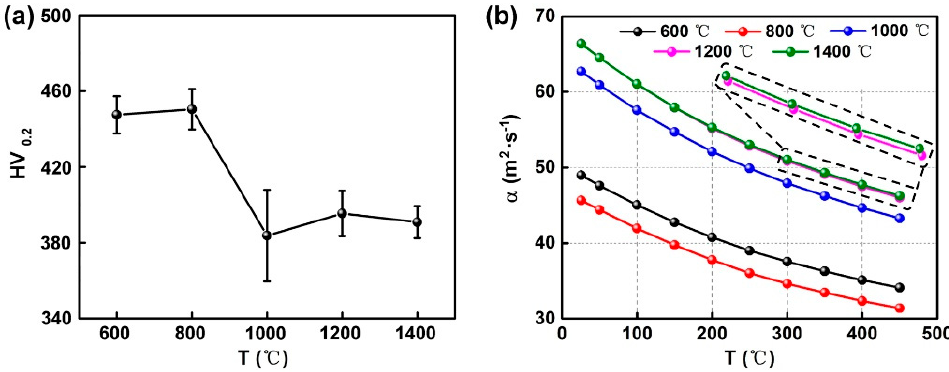
Figure 7. ( a ) The Vickers hardness and ( b ) the thermal diffusivity of the W foil laminates as a function of the joining temperature.